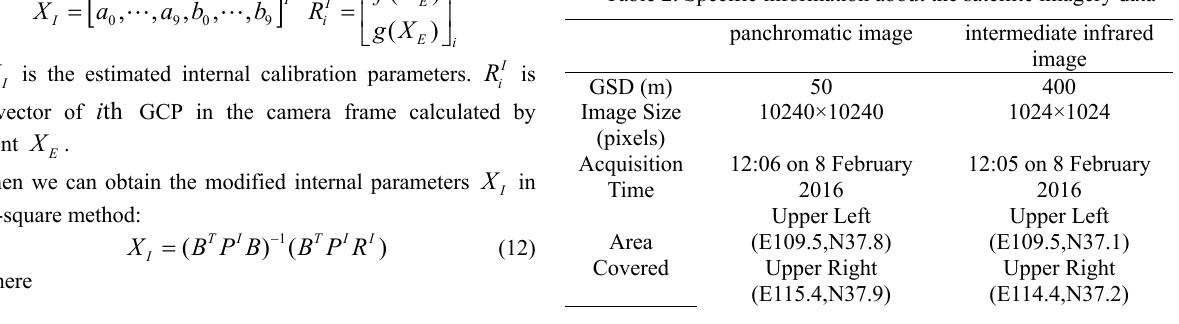
Figure 2. The selected satellite imagery and reference data Detailed information about the satellite imagery data and reference data are listed in Tables 1 and 2, respectively. Table 2. Specific information about the satellite imagery